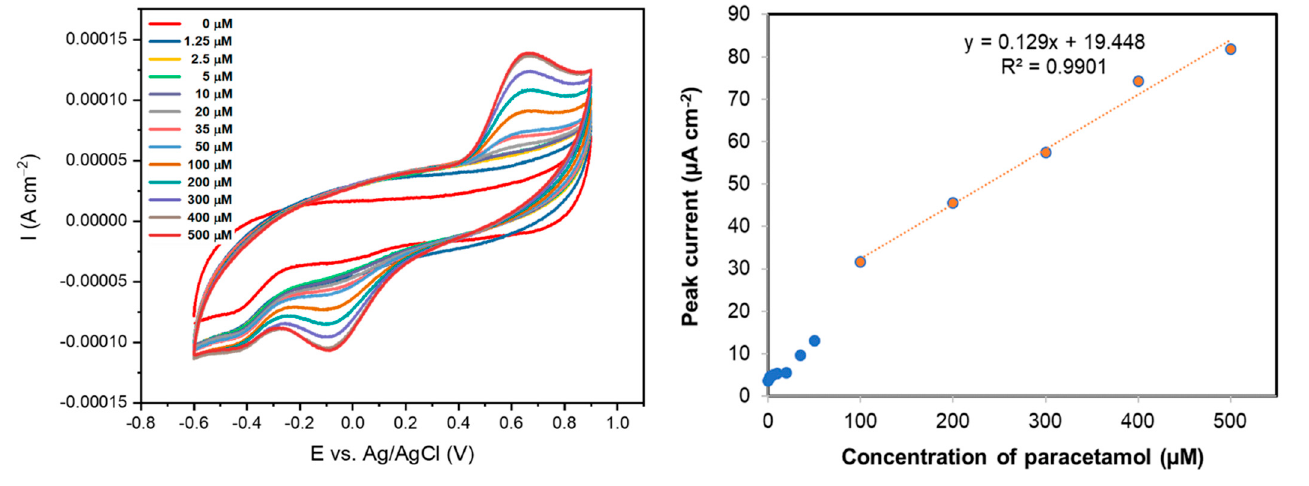
Figure 4. ( left ) Cyclic voltammograms (50 mV s − 1 ) of paracetamol (0–500 µM) in 0.1 M PBS solution using a carbon fibre coated with rGO deposited using 5 CV cycles; ( right ) Calibration curve for the same rGO-coated carbon fibre in solutions of paracetamol (0–500 µM) in 0.1 M PBS